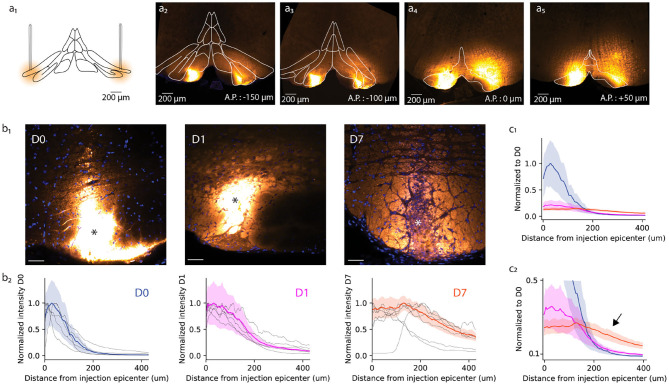
Anatomical study of A6+ spread within the inferior olive. (a) Schematic representation of bilateral injection of A6+ into dorsal accessory olive. (a2–a5) Example of A6+ spread in medio-lateral and antero-posterior directions imaged a few hours after injection. (b1) Mesoscale A6+ staining intensity becomes more uniform after injection (D0, D1, and D7 signify time points of a few hours, 1 and 7 days, respectively). (b2) Quantification of the changes shown in (b1), represented in a radial plot profile as a peak intensity ratio. (c1) Radial plot profile normalized to D0 average peak intensity value shows that A6+ is cleared quickly from the injection site between D0 and D1, and further but slower until D7. (c2) This decrease is accompanied by an broadening of the stained zone (indicated by arrow).